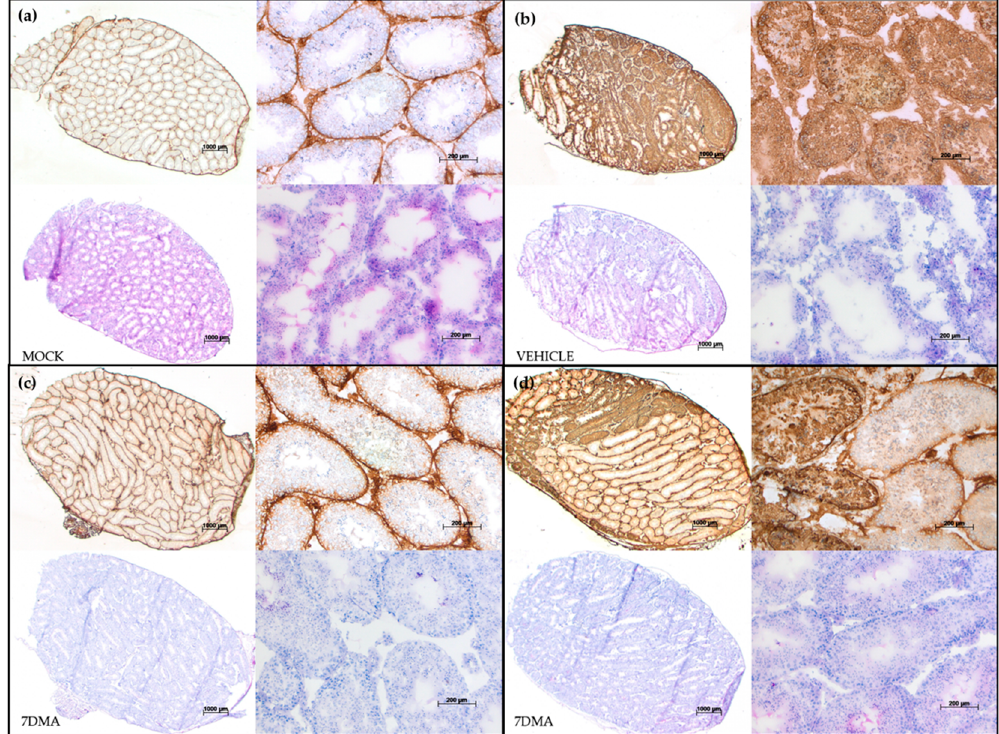
Figure 2. Testicular levels of ZIKV antigens are reduced after 7DMA treatment as visualized by histopathological staining. Inoculation and treatment of AG129 mice was performed as described in Figure 3. The presence of ZIKV antigens (top panels in each quadrant) and inflammation (bottom panels in each quadrant) in the testis at day 10 pi is compared between mock-infected mice ( a ) and ZIKV-infected mice treated with vehicle ( b ) or 7DMA ( c , d ). The top two panels in each quadrant show antibody staining for the ZIKV envelope protein. The bottom two panels in each quadrant show hematoxylin and eosin staining. Panels on the left in each quadrant show a complete cross section of the testis. Panels on the right of each quadrant show a close up of the complete cross section of the same quadrant. The scale bars are 1000 µm and 200 µm for cross sections and close ups, respectively.